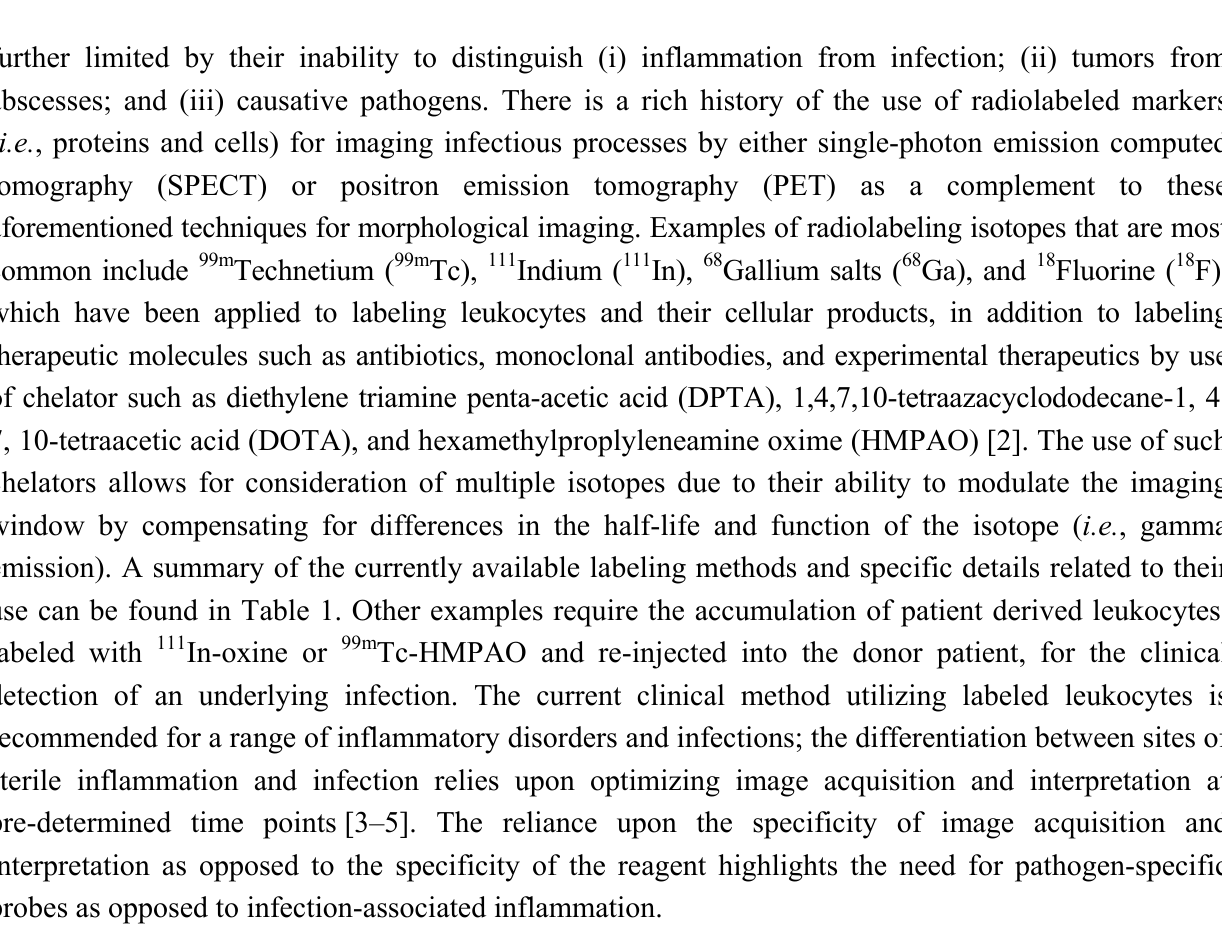
Table 1. Summary of labeling reagents available for pre-clinical and clinical